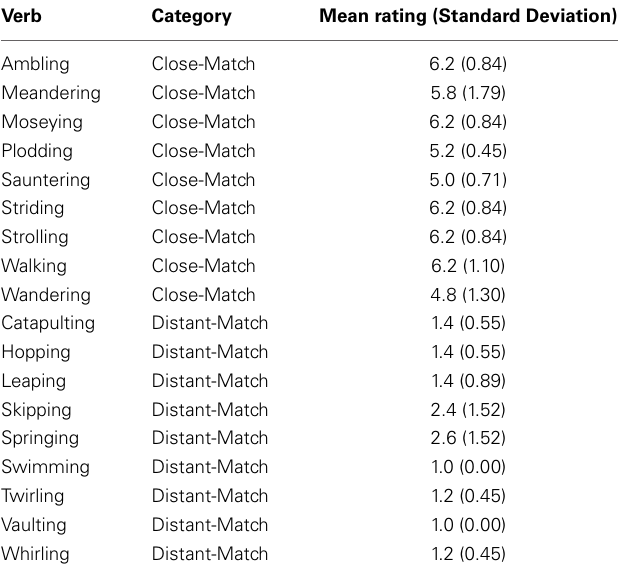
Table 1 | Ratings for Close-Match and Distant-Match verbs used in the